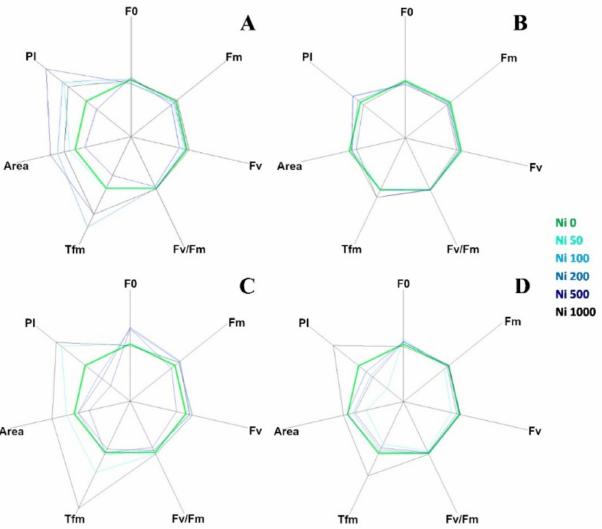
Figure 4. Fluorescence transient analysis of test species represented by spider plots: ( A ) A. utriculata , ( B ) N. caerulescens , ( C ) A. montanum , ( D ) T. arvense . Parameters considered: F0: dark level fluorescence, Fm: maximum fluorescence, Fv: variable fluorescence, Fv/Fm: maximum efficiency of photosystem II (PSII), Tfm: time (ms) to reaching Fm, Area: area above the fluorescence curve between F0 and Fm, P.I. performance index. Increasing concentrations of nickel correspond to darker shades of blue; green identifies the control. Data are standardized for Ni 0 mg kg − 1 . Data are the mean of ten measurements per plant. n = 300 each species.